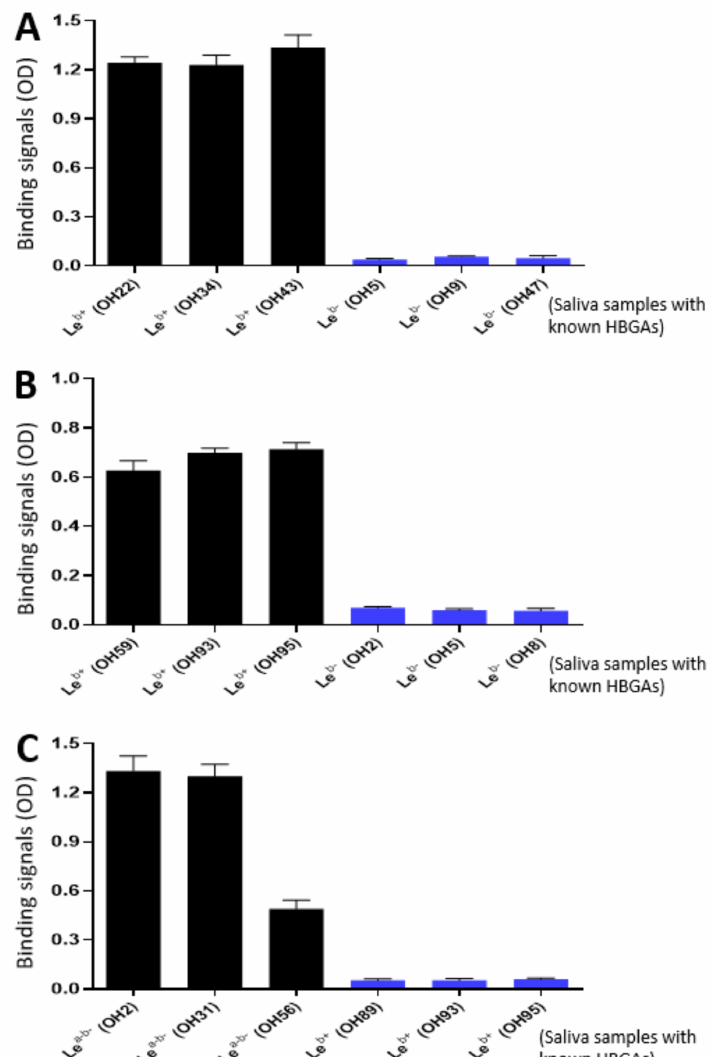
Figure 4. Interactions of the three P 24 -VP8* nanoparticles with glycan ligands in the well-characterized saliva samples. ( A and B ) The P 24 -VP8* P[8] ( A ) and the P 24 -VP8* P[4] ( B ) nanoparticles bound Le b positive, but not Le b negative saliva samples. ( C ) The P 24 -VP8* P[6] nanoparticles bound saliva samples with Le a-b- , but not Le b+ phenotypes. The Y-axis shows binding signals in optical density (OD), while the X-axis indicates various saliva samples with known HBGAs that are coded from OH1 to OH96 from our lab